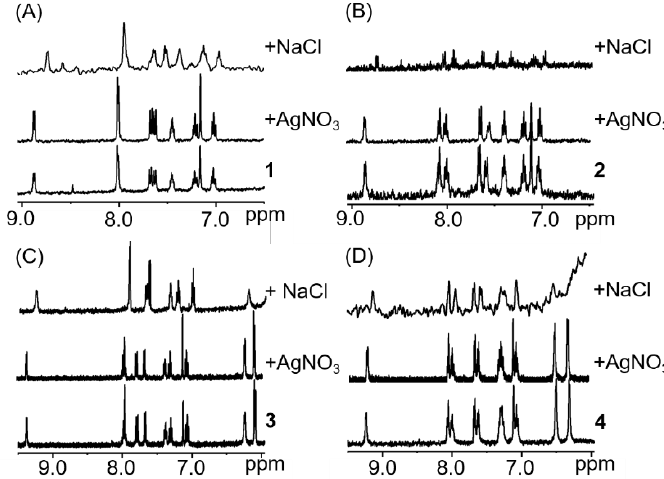
Figure 2. 1 H-NMR spectra of complexes 1 – 4 ( A – D , respectively) in the presence of silver nitrate or sodium chloride, (1.1 mM complex, MeOD / D 2 O 1:1 v / v , pH 7.4, 298 K). Weak signals and low signal-to-noise ratios are due to the precipitation of the neutral chlorine complex adduct after addition of chlorine.